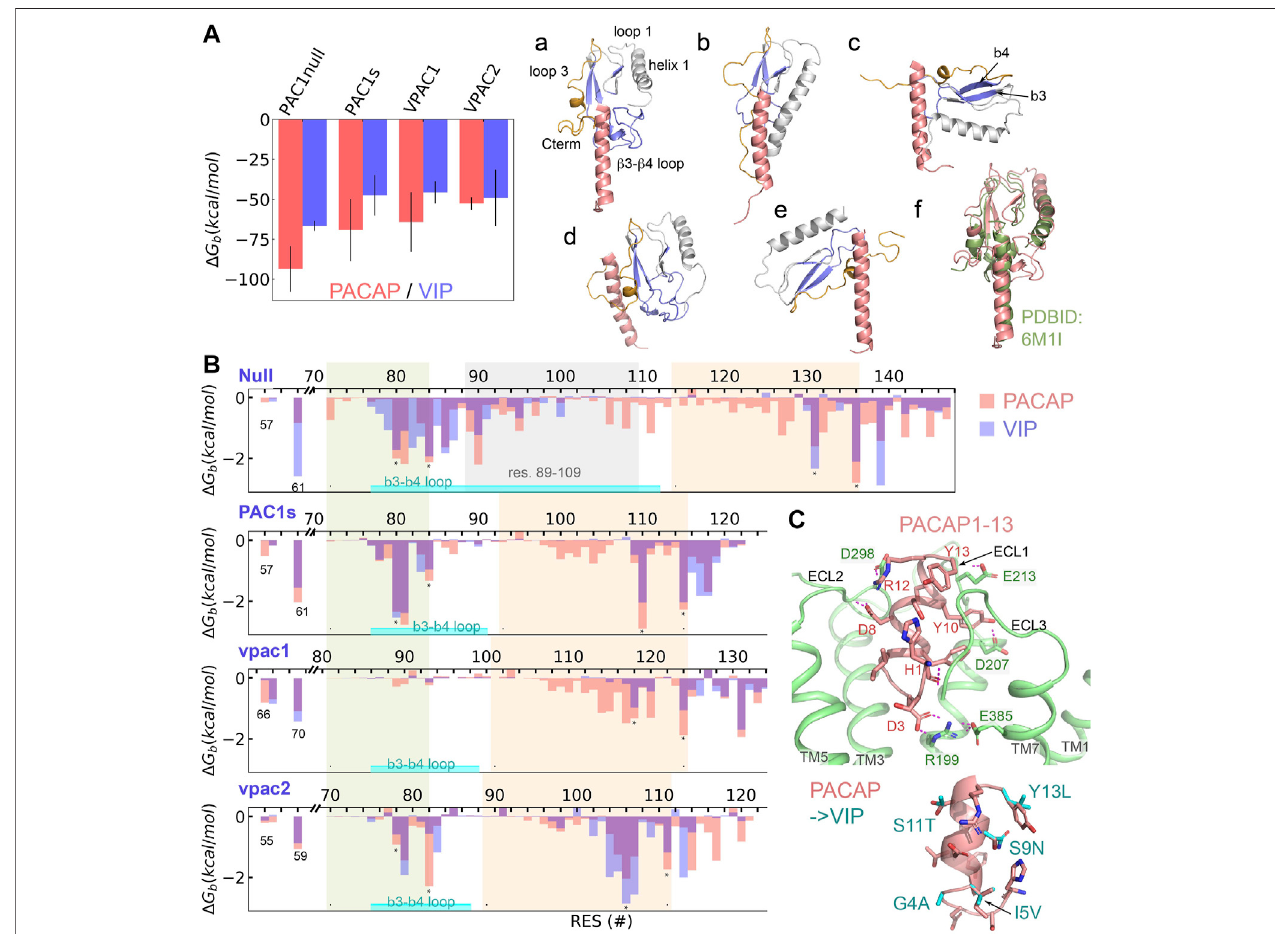
FIGURE2| BindingselectivityandrecognitionofPACAPandVIPonPAC1null,PAC1s,VPAC1andVPAC2receptors. (A) Bindingfreeenergy( Δ G b )ofPACAPand VIP on PAC1null, PAC1s, VPAC1 and VPAC2 receptors respectively by averaging the Δ G b values from fi ve replicas with bars representing the standard